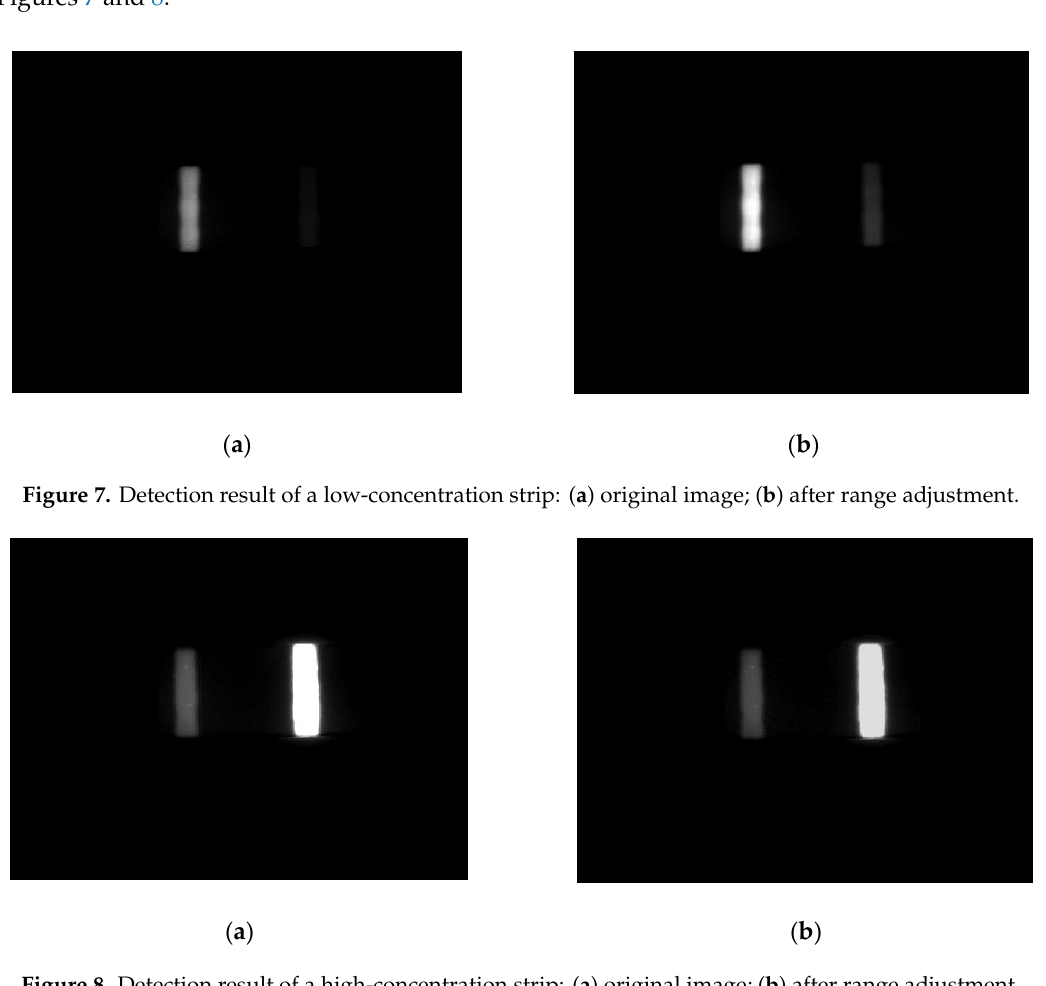
Figure 8. Detection result of a high-concentration strip: ( a ) original image; ( b ) after range adjustment.